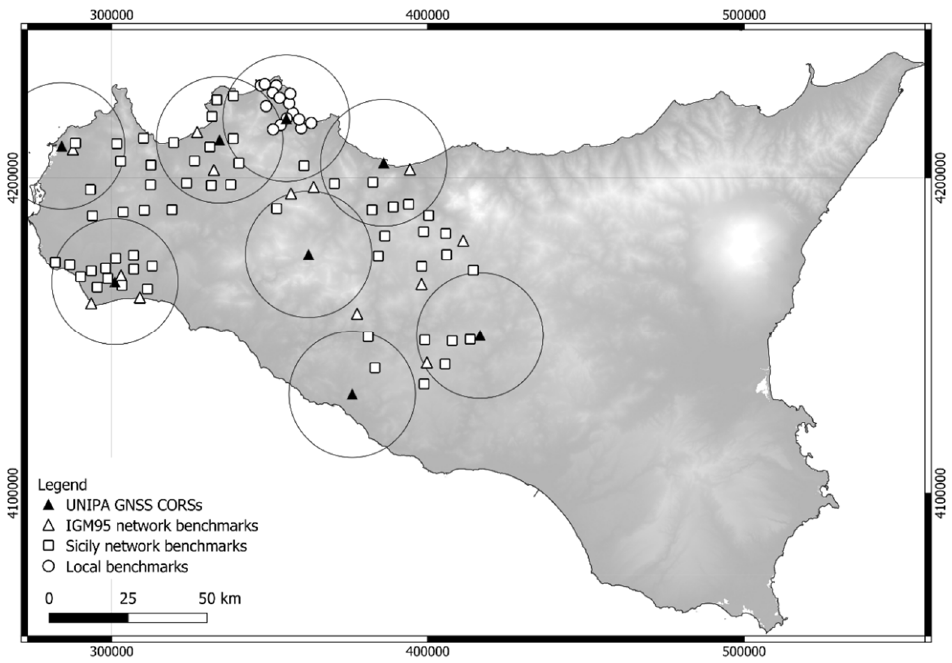
Figure 1. UNIPA GNSS CORSs (black triangles) and GNSS reference benchmarks (IGM95 network benchmarks, white triangles; Sicily network benchmarks, white squares; local benchmarks, white circles); 20 km buffer circles from the GNSS CORS are shown. Reference system UTM-WGS84 33N (ETRF2000-RDN2008)-EPSG6708.